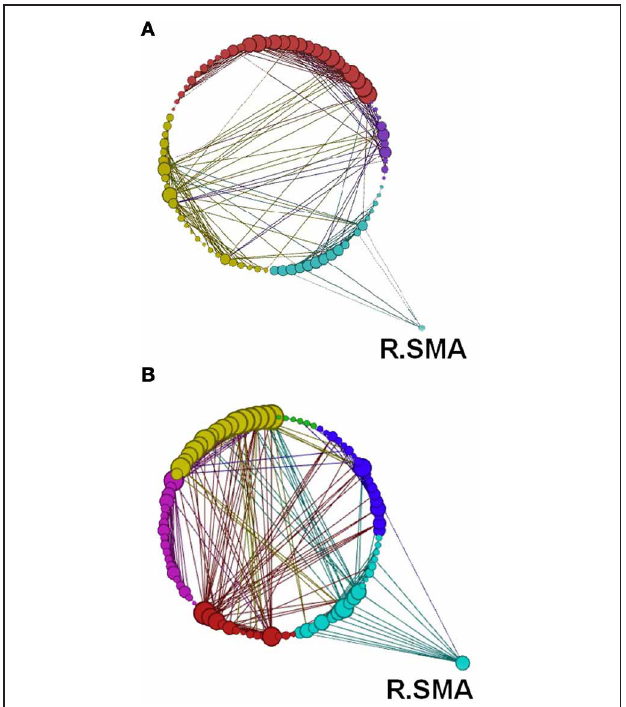
FIGURE 15 | Network modularity following the visuo-motor performance task, in the same format at Figure 12 and same Color scheme same as Figure 14. Table 1 | Brain regions with increased participation